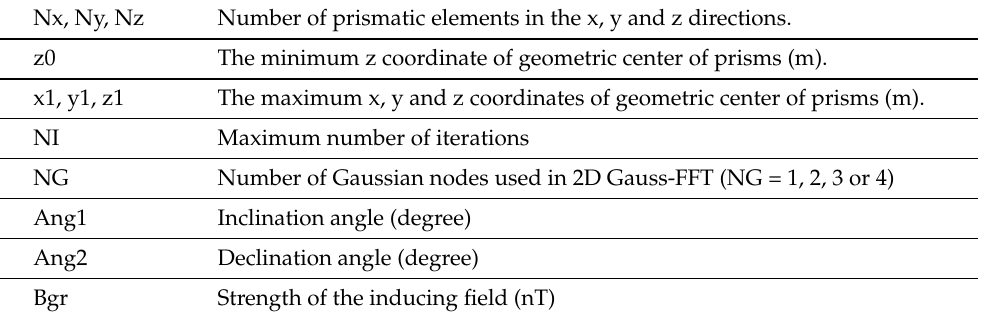
Strength of the inducing field (nT)